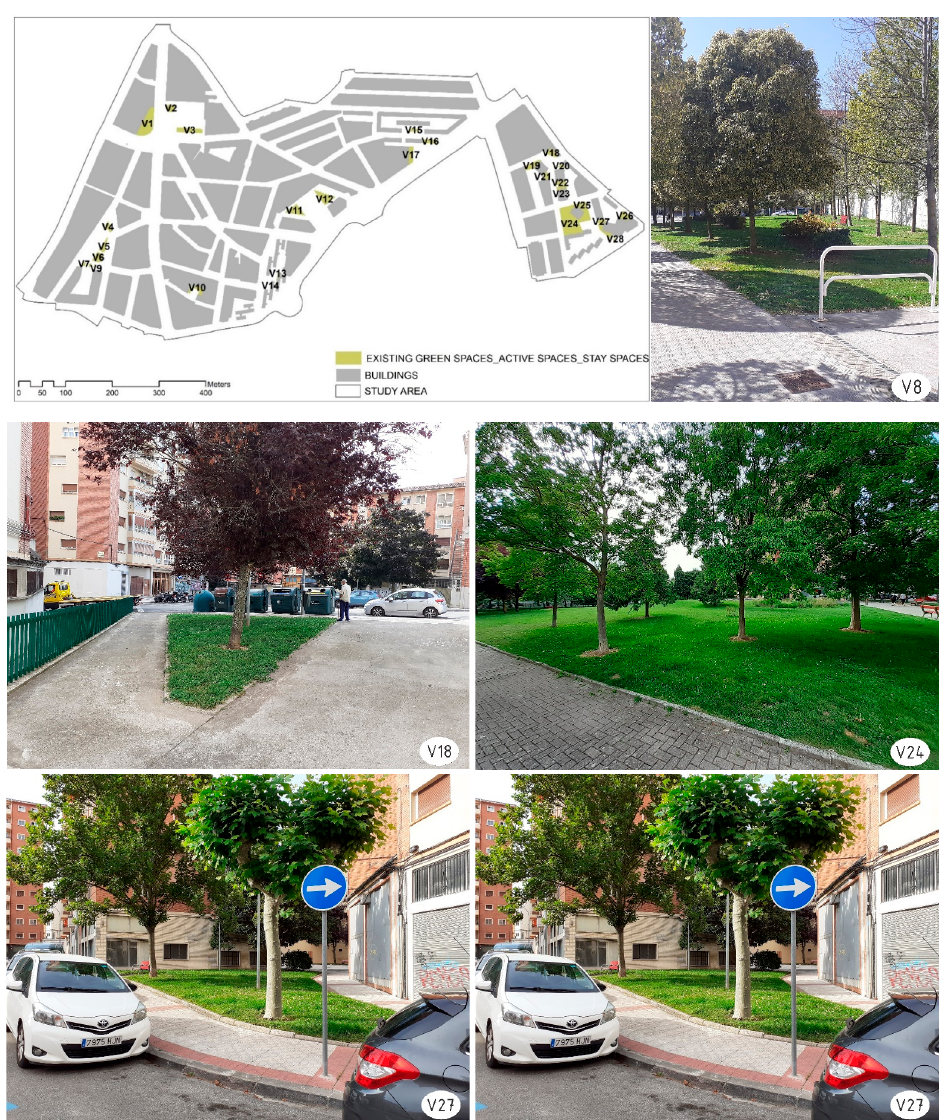
Figure 6. Existing green spaces: spaces for staying.